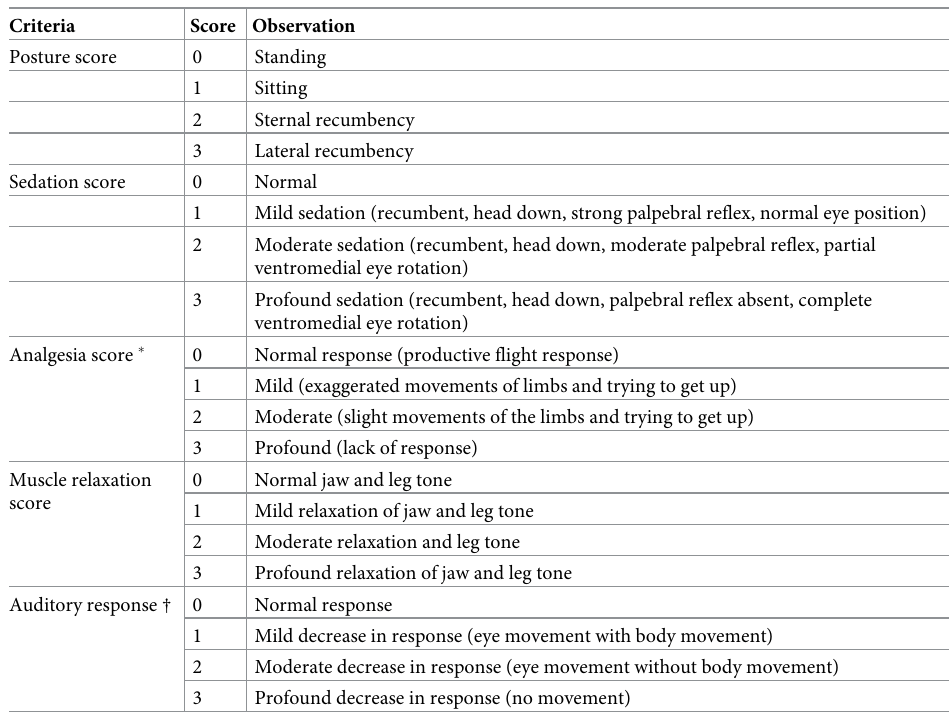
Table 1. Anesthesia